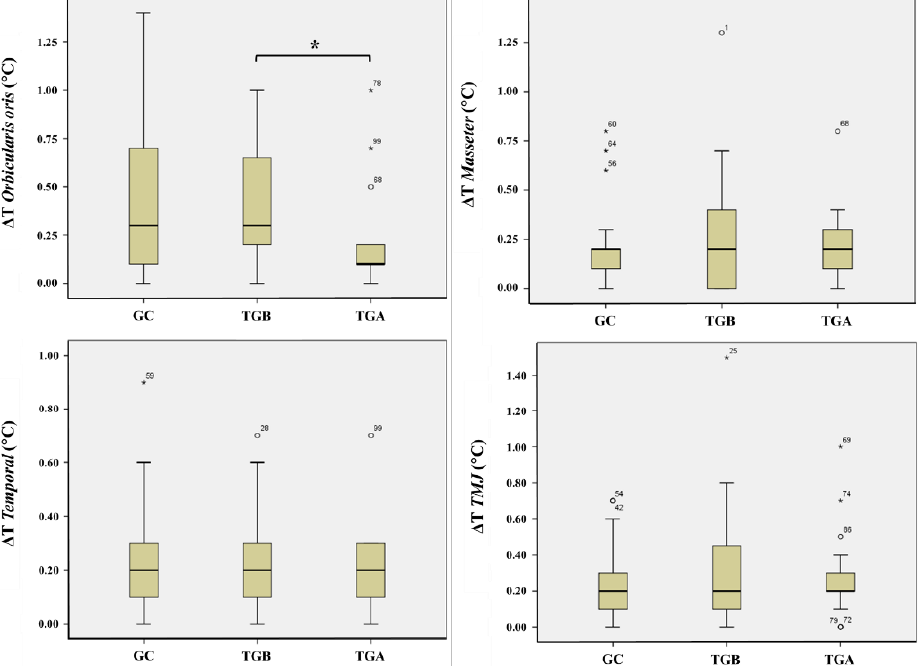
Figure 5. Box-and-whisker plots of the thermal difference ( ∆ T) for each ROI of the control group (CG) and treatment group, before and after oral rehabilitation (TGB and TGA, respectively). The asterisk ( * ) mark the statistical difference found for the Oo when comparing TGB with TGA. Table 2. Statistical data analysis of the intra- and inter- group comparisons of the ΔT values of each ROI.